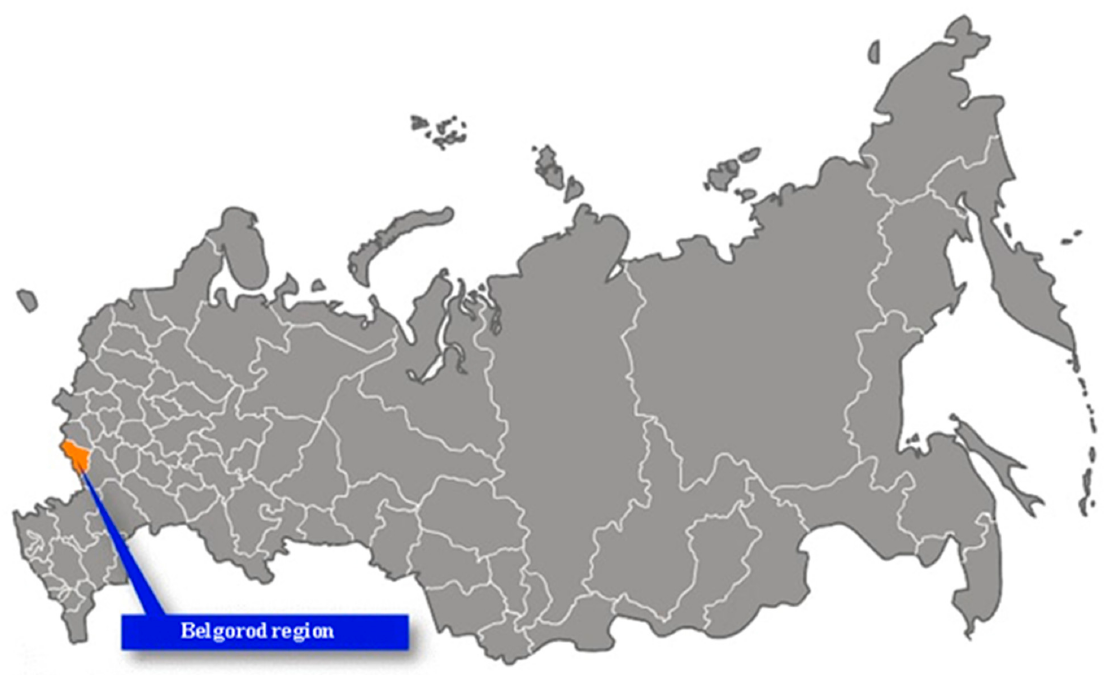
Figure 1. The location of the study region in relation to the Russia.